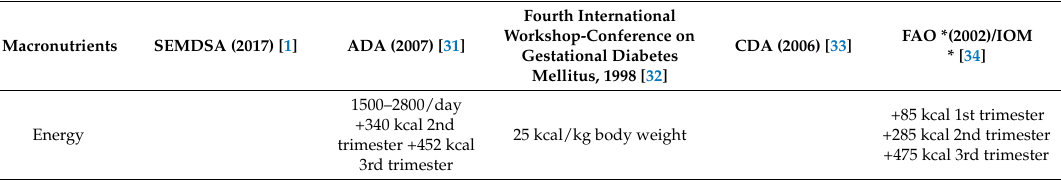
Table 1. Dietary recommendation in Gestational Diabetes from different